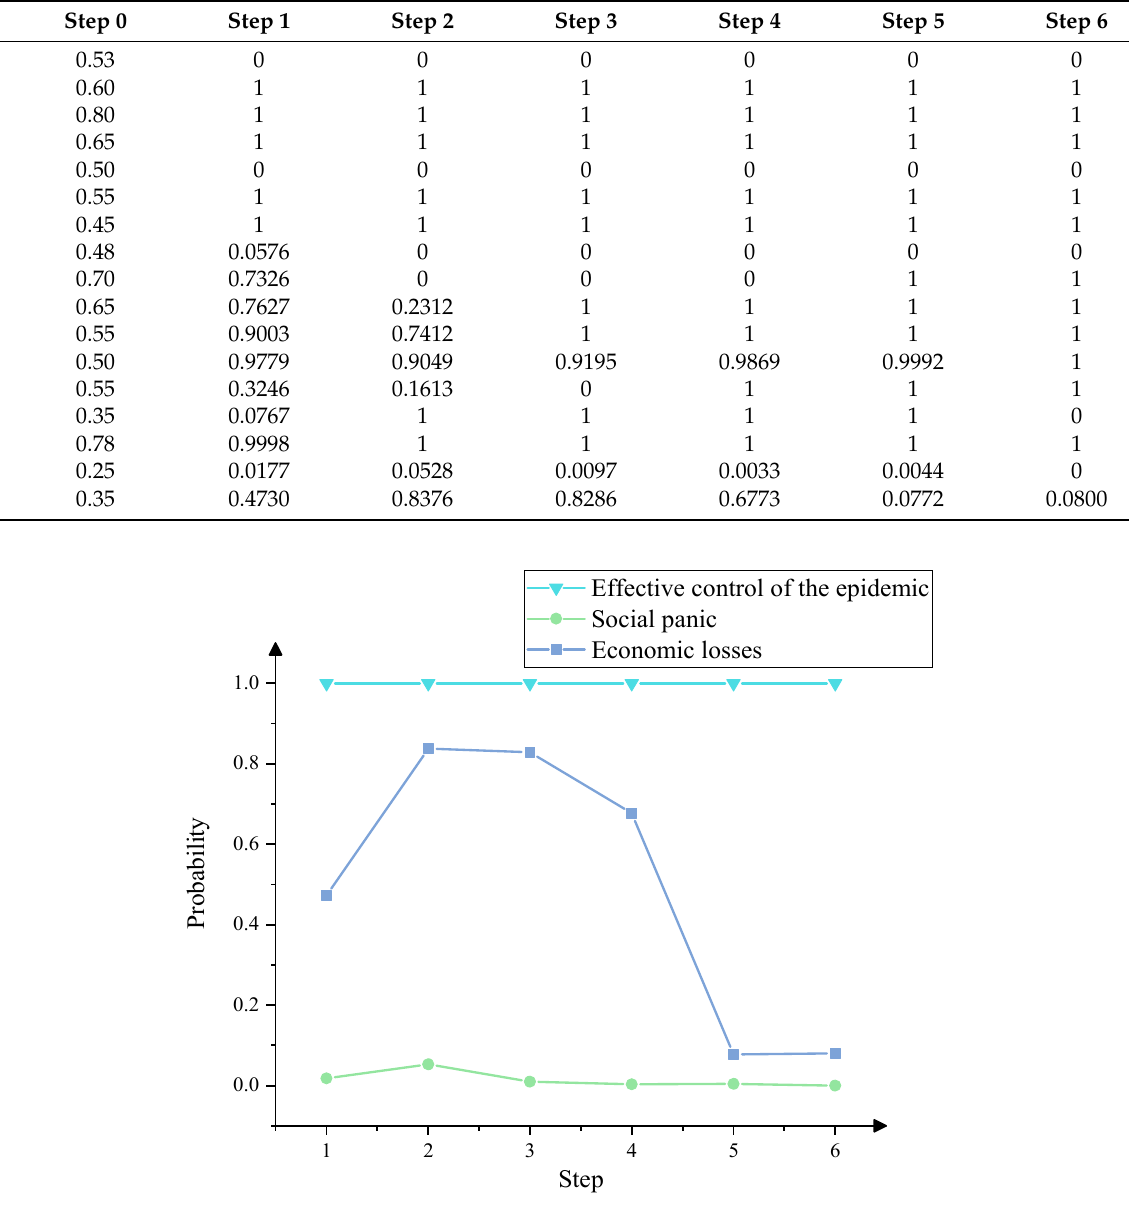
Table 16. Prediction probabilities for each scenario.